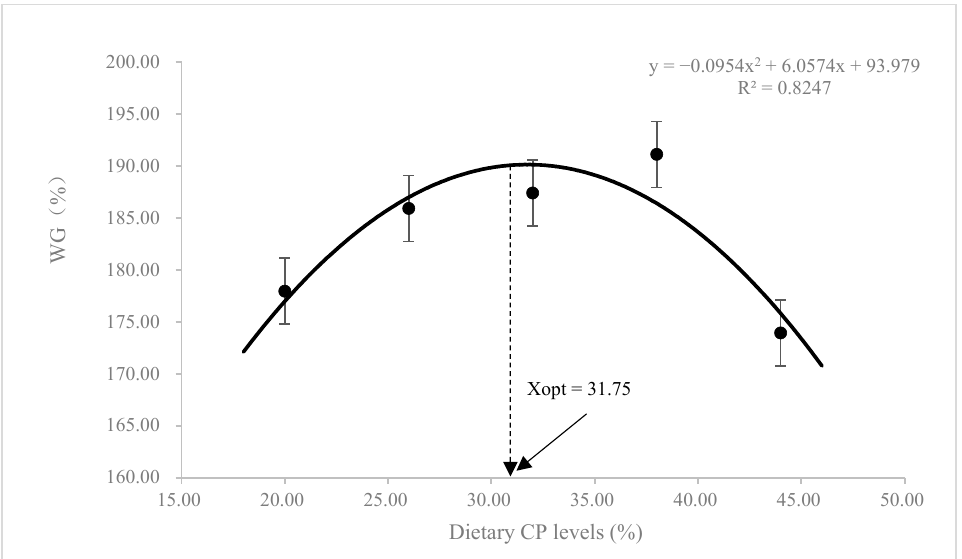
Figure 1. Relationship of weight gain (WG) with dietary crude protein (CP) levels of juvenile K. punctatus .